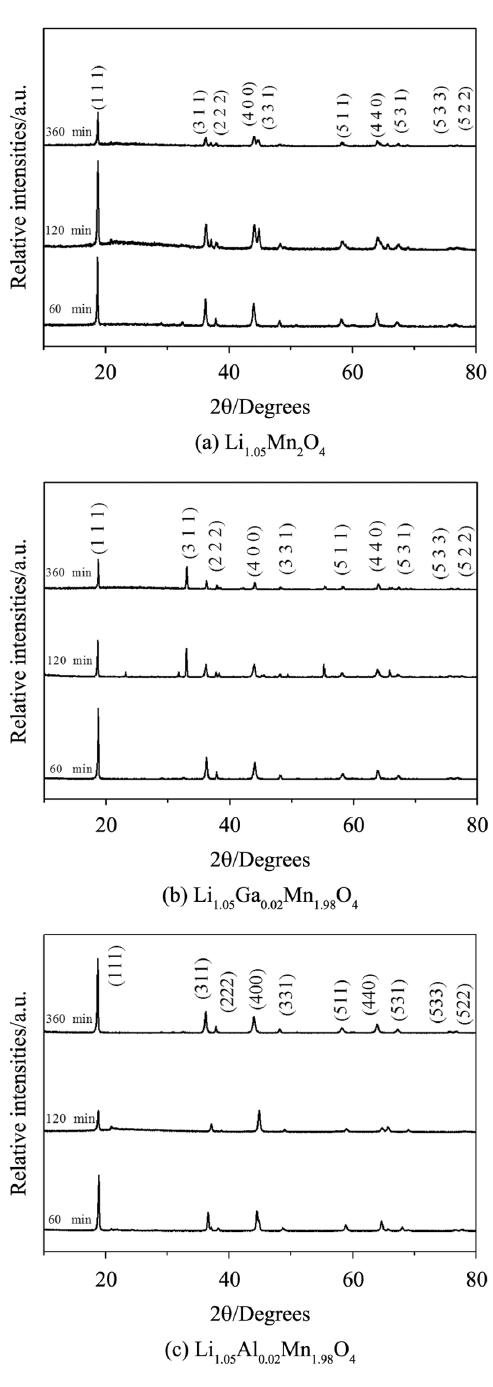
Figure 4. XRD patterns of the: (a) Li (c) Li